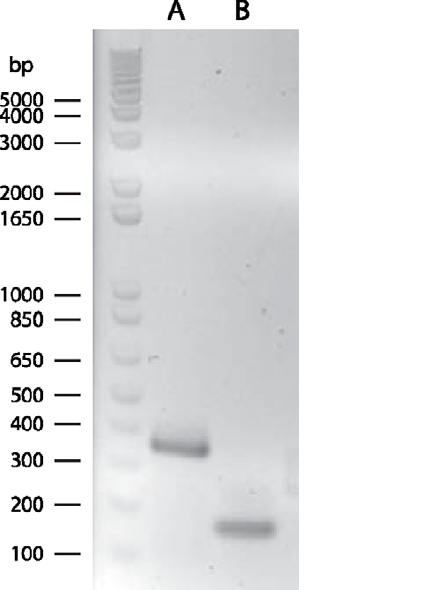
Figure 3. Electrophoretic analysis of RT-PCRs performed on Helicosporidium total RNA. The amplicon in lane A corresponds to the expected size (343 bp) between the two internal cox1 primers in exons 2 and 3 (Hecox1F & Hecox1R) after trans -splicing of the Hsp. cox1 .2 group I intron. The amplicon in lane B corresponds to the in cis positive control (166 bp) performed with internal atp1 primers (07487R & 00085R).